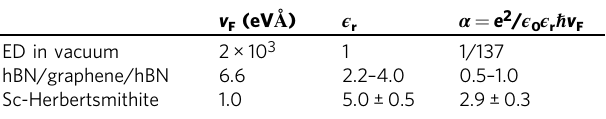
Table 1 Dirac fl uid